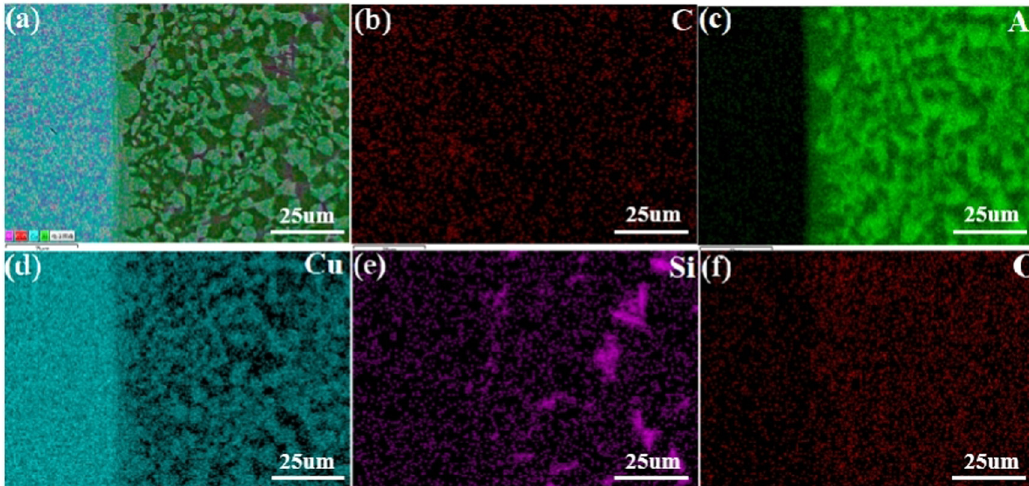
Figure 3: EDS distribution diagram of Cu side brazing joint interface: ( a ) surface scanning, ( b ) C, ( c ) Al, ( d ) Cu, ( e ) Si, and ( f )